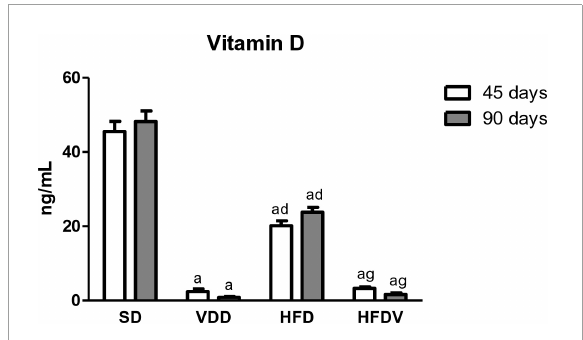
FIGURE1 Plasma 25(OH)D levels evaluated at 45 and 90 days of protocol in rats submitted to renal ischemia-reperfusion insult on day 45 treated with standard diet (SD), vitamin D-free diet (VDD), high-fat diet (HFD), or high-fat vitamin D-free diet (HFDV). Data are mean ± SEM. a p < 0.001 vs. SD; d p < 0.001 vs. VDD; g p < 0.001 vs .